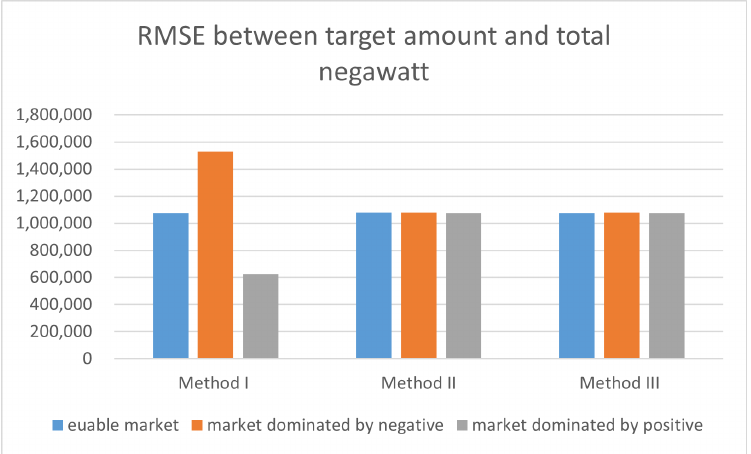
Figure 2. RMSEbetween the target amount of power saving and total negawatts.